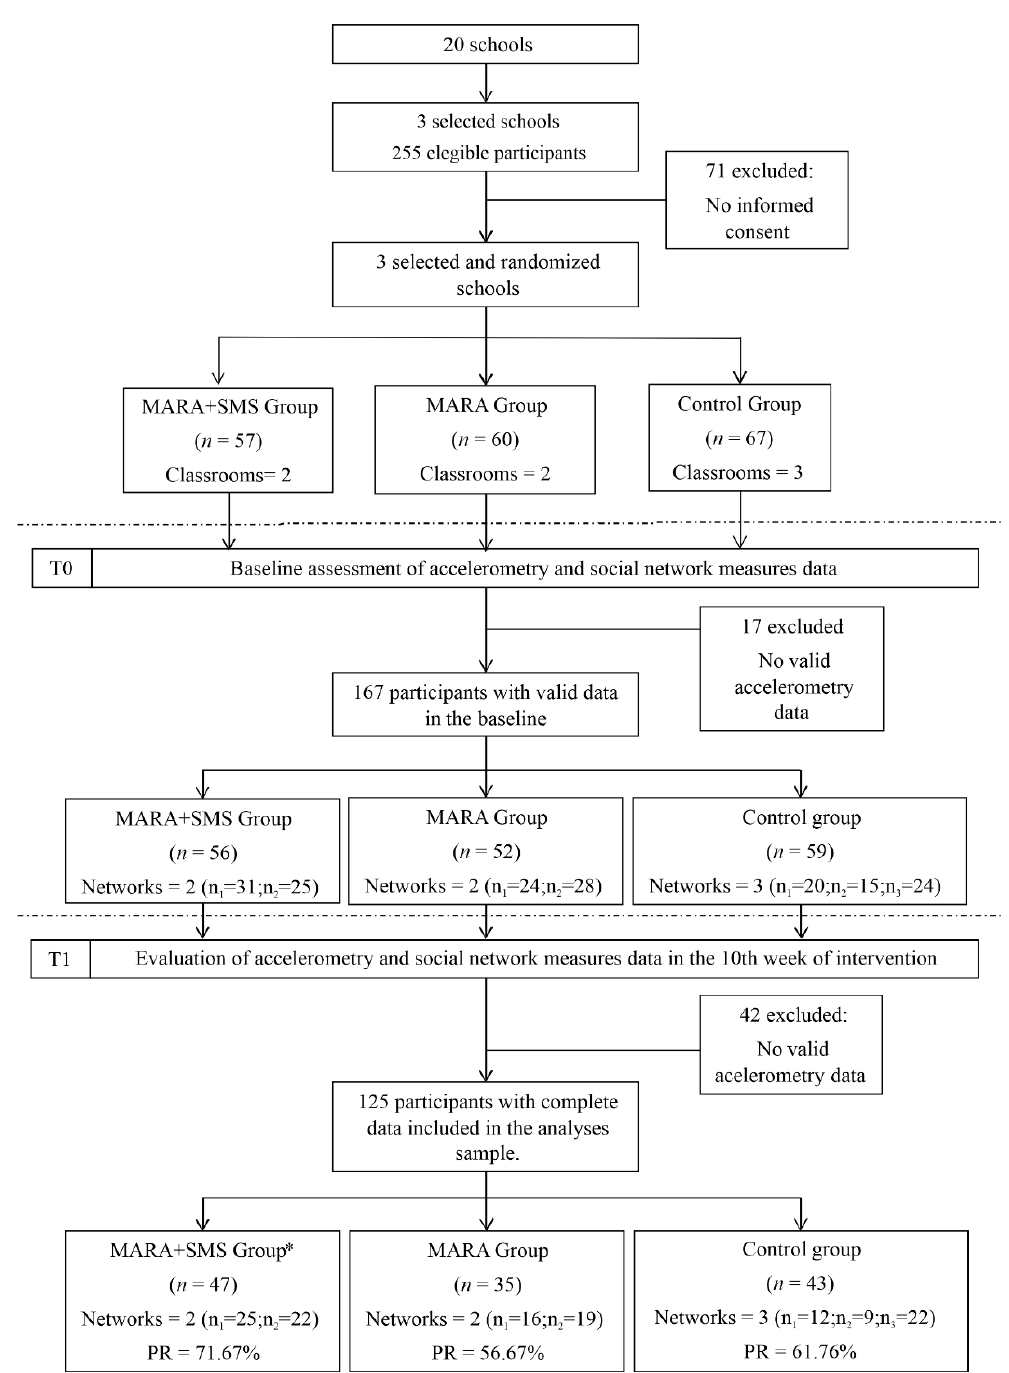
Figure 1. Consort flow diagram of the intervention. Modulo Activo Recreo Activo (MARA) is the Spanish acronym for “active and recreo-active module”, and PR means participation ratio. * A participant dropped out before week 10, but he/she was included in the analysis with the intention-to-treat analysis.